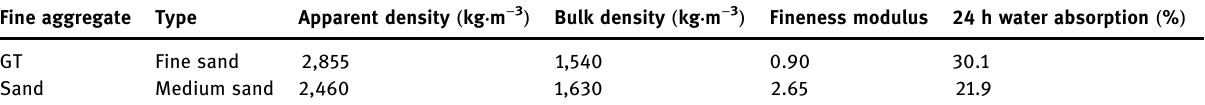
Table 3: Physical properties of fi ne aggregate Fine aggregate Type